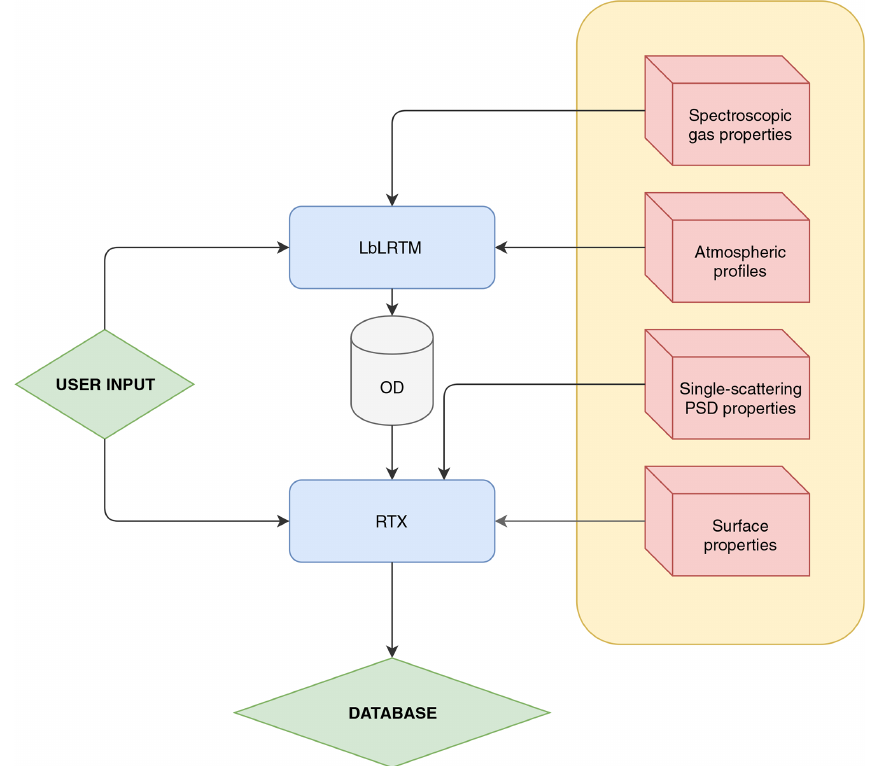
Figure 1. Software architecture (schematic) of the simulation process used to build the synthetic dataset for FORUM-like observations. Blue boxes are codes and red boxes are auxiliary datasets. OD stands for gaseous optical depths computed using the Line-by-Line Radiative Transfer Model (LbLRTM) version 12.7 (Clough et al., 2005). The radiative transfer X (RTX) is described in Bozzo et al. (2010). The Fourier transform spectroscopy and the simulation of FORUM noise are included in the RTX box.